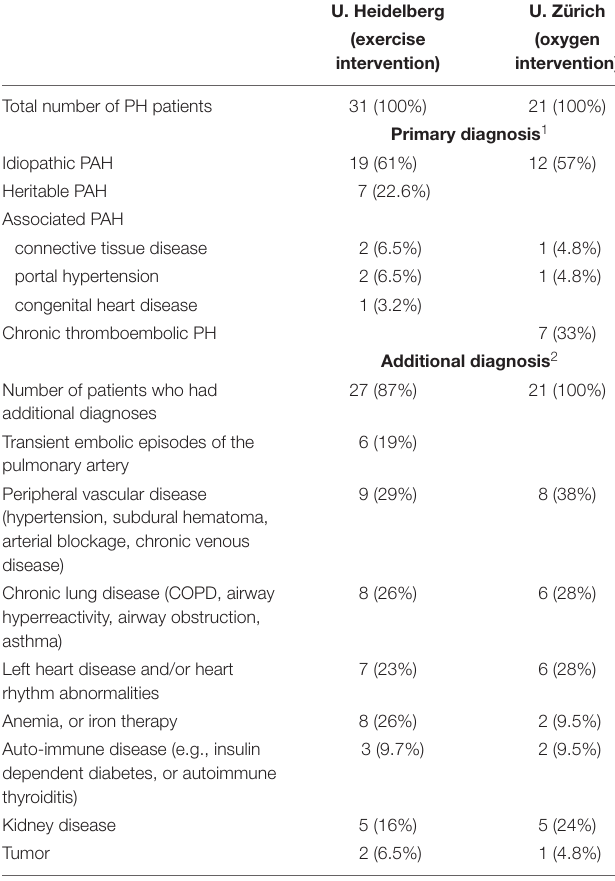
TABLE 2 | Diagnoses for PH